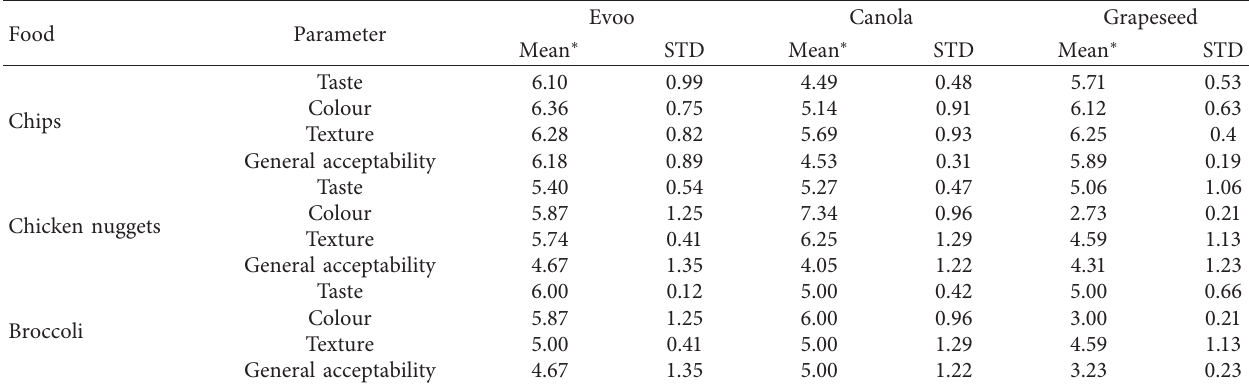
Table 1: Sensory